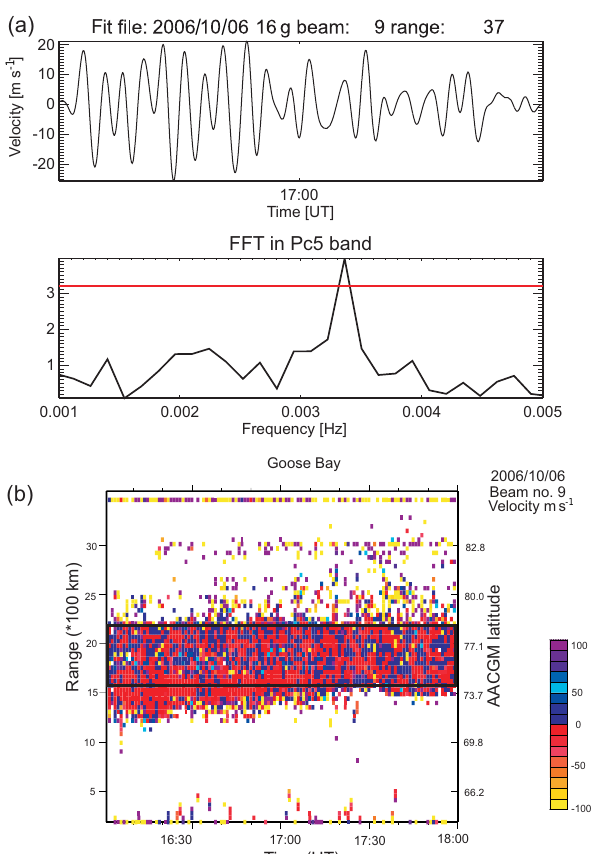
Figure 5. Event 3: (a) the top panel shows Pc5 band-filtered Doppler velocity data from the Goose Bay radar. The lower panel contains the corresponding power spectrum together with the sig- nificant limit level from filtered data. The peak detector recorded the peak in frequency band 1.4–1.7mHz as significant. (b) A time– range summary plot of Doppler velocity in metres per second mea- sured by beam 10 of Goose Bay radar showing range and AACGM